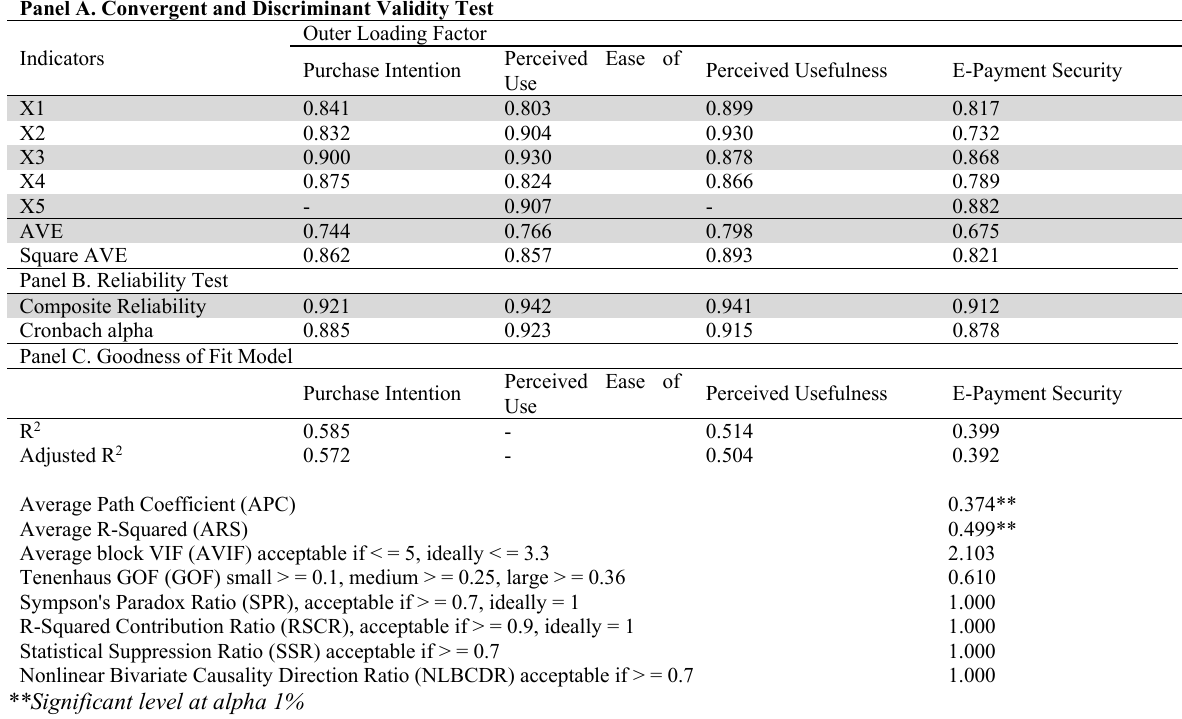
Validity, Reliability, and Goodness of Fit Model Panel A. Convergent and Discriminant Validity Test